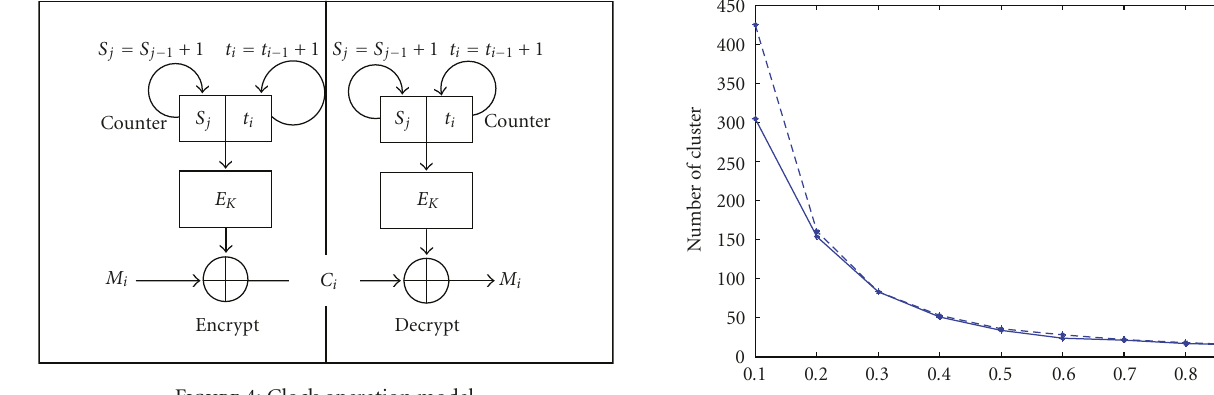
Figure 4: Clock operation model.